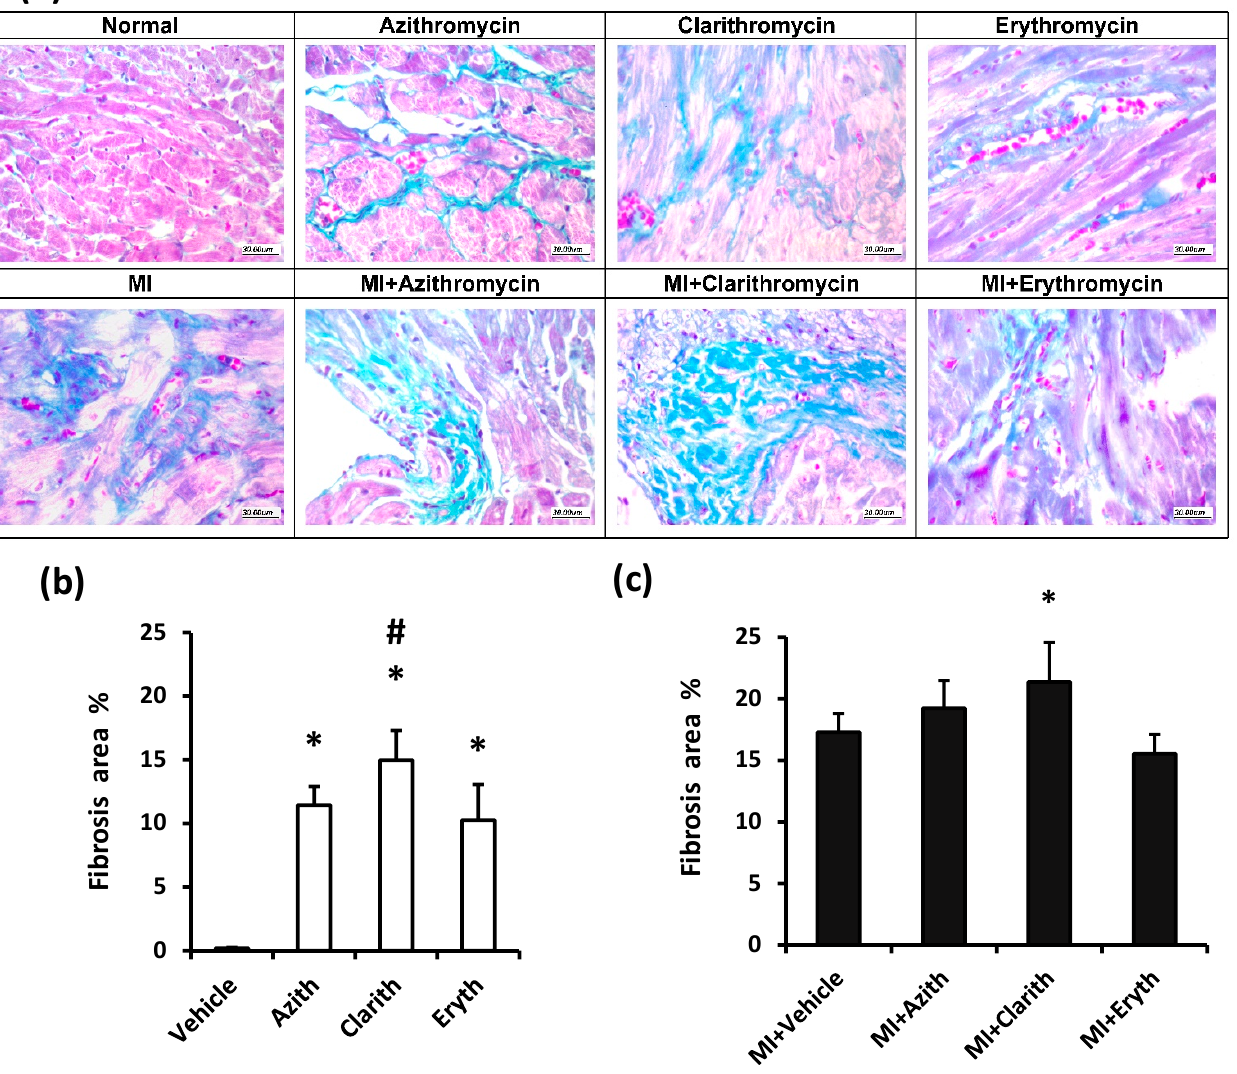
Figure 5. Masson’s trichrome staining for cardiac specimens in the two rat experiments. ( a ) Images for specimens were taken from healthy or MI rats treated with azithromycin (Azith), clarithromycin (Clarith), or erythromycin (Eryth). ( b ) Fibrosis % for healthy rat experiment and ( c ) Fibrosis % for MI rat experiment. MI: myocardial infarction. Data are medan ± standard deviation for each set’s histologic score analyzed separately by one-way ANOVA and Bonferroni’s test. * p -value less than 0.05, different from the vehicle group. # p -value less than 0.05: different from the azithromycin group of the same experiment ( n = 4–6).